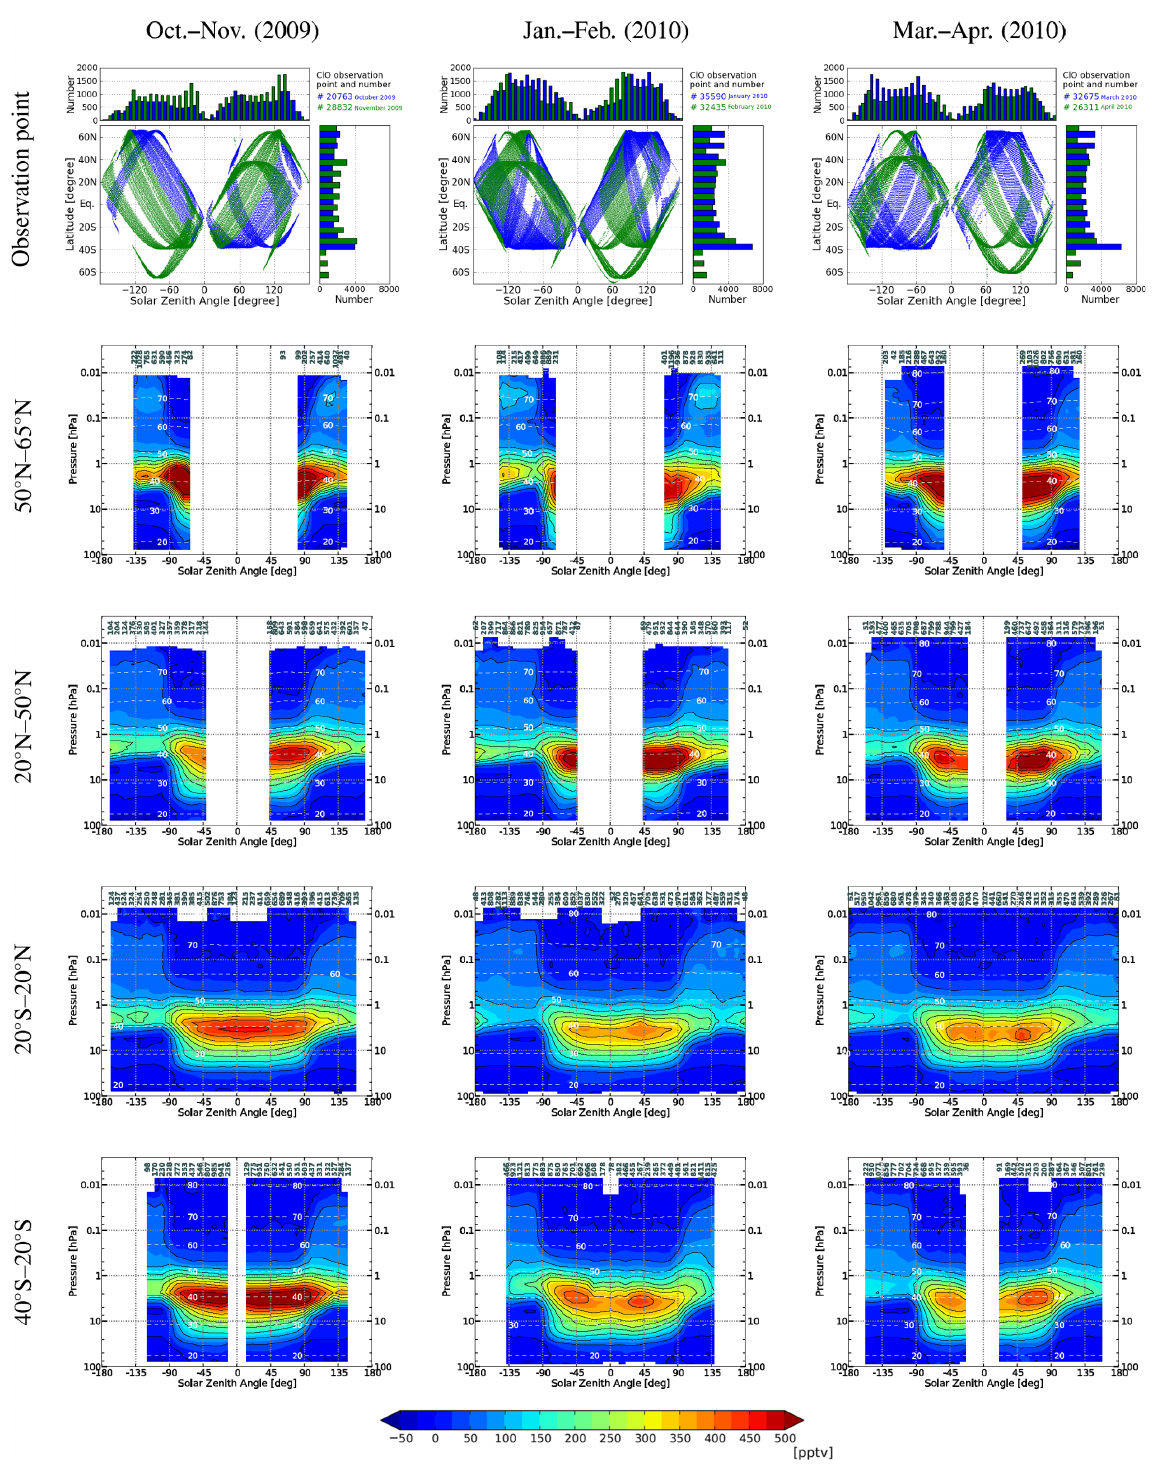
Fig. 11. Seasonal and latitudinal variations in the ClO diurnal variations as a function of SZA and pressure for October–November 2009, January–February 2010 and March–April 2010 and latitudes (50 ◦ N–65 ◦ N, 20 ◦ N–50 ◦ N, 20 ◦ S–20 ◦ N and 40 ◦ S–20 ◦ S). The color contour levels are separated by 25pptv. The altitude is represented by the white dotted line. The numbers of averaged profiles in SZA bins of 10 ◦ are indicated at the top of each panel. Only retrieved VMR values that satisfy χ 2 < 1 and m> 0.8 are used. The observation points in the top row are represented by dots of different colors for each month. The numbers of scans in an SZA bin of 10 ◦ and a latitude bin of 10 ◦ are represented by bars at the top and above and to the right. The total number of scans is given at the upper